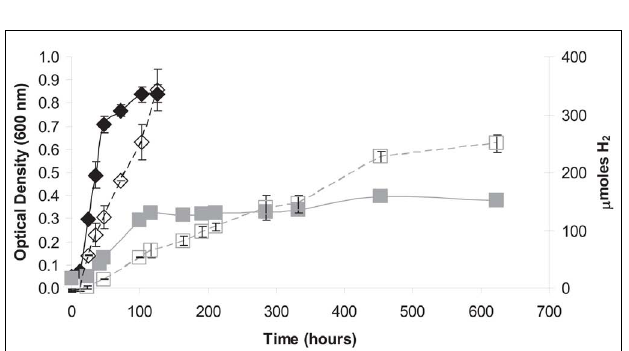
FIGURE 4 |Agitation of H. hydrogenoformans cultures growing on cellobiose resulted in increased growth yield and rate ( (cid:2) ) as well as greater H2 yield and production rate ( ♦ ) as compared to growth ( (cid:6) ) and H2 production ( (cid:3) ) in non-agitated cultures. A concomitant increase in the rate of cellobiose degradation and acetate production were observed with agitation (data not